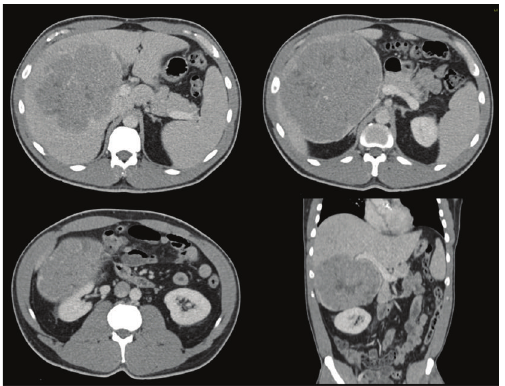
Figure 5: Abdomen and pelvis CT that shows a right-sided retroperitoneal recurrent mass prior to cryoablation.